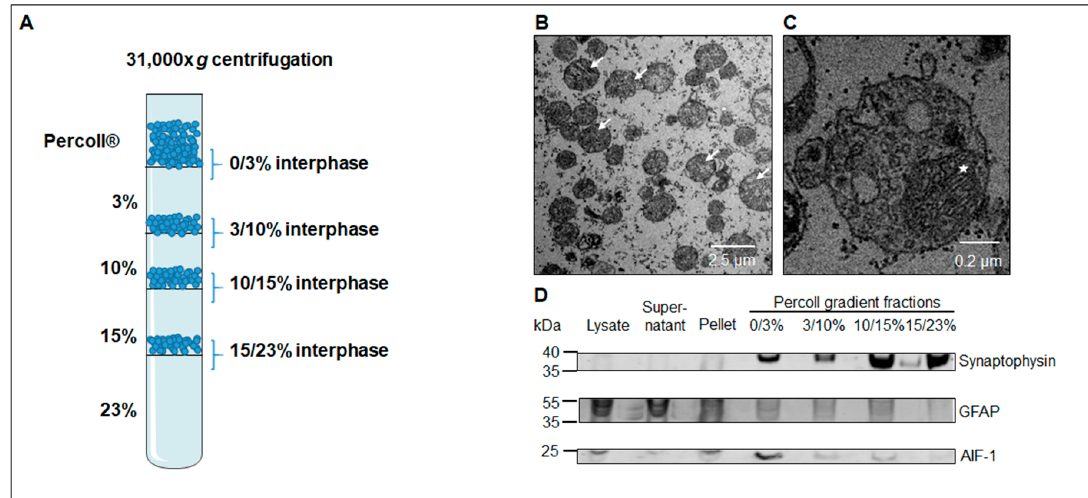
Figure 2. Quality control of synaptosomes enrichment. ( A ) Graphical image of the Percoll gradient for synaptosome enrichment. ( B , C ): Transmission electron microscopic analysis of density gradient fraction 15 / 23% Percoll at 10,500 × ( B ) or 60,000 × ( C ) magnification. At 10,500 × magnification, no organelle contaminations could be observed but enrichment of synaptosomes (arrows) was obvious ( B ). Analysis at higher magnification showed synaptosomes contained mitochondria (asterisk) besides vesicles, underlining that synaptosomes resemble synapses. ( D ) Western blot analysis of di ff erent Percoll gradient fractions. Percoll fraction 15 / 23% did not contain astrocytes (indicated by GFAP) or microglia (indicated by AIF-1) and was identified as the purest synaptosomal fraction for further analysis.